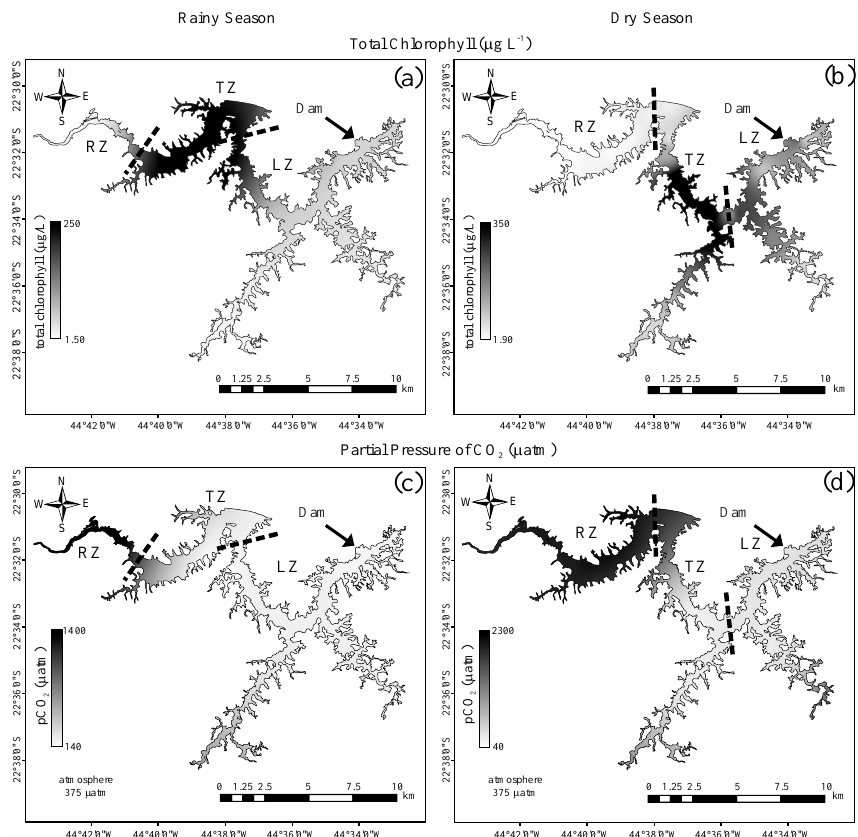
Figure 2. Map of p CO 2 and Chl as expressed by a color gradient obtained from interpolation of measured data using ordinary kriging statistics. The root-mean-square error (RMSE) of the kriging prediction, calculated by comparing observed and calculated values, was 90µatm and 15µgL − 1 for p CO 2 and Chl, respectively. Lighter gray represents low Chl (a, b) and low p CO 2 (c, d) . RZ: riverine zone; TZ: transition zone; LZ: lacustrine